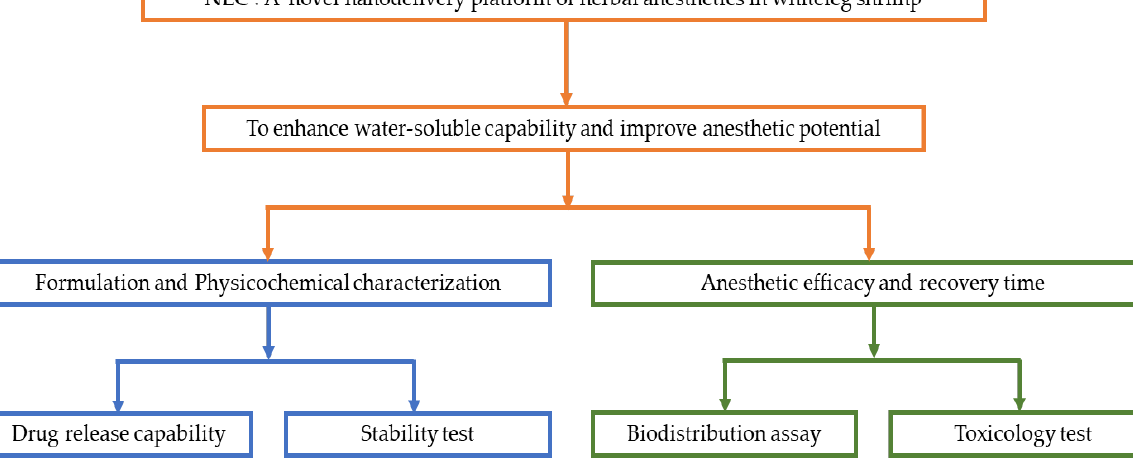
Figure 1. Schematic overview of the experimental